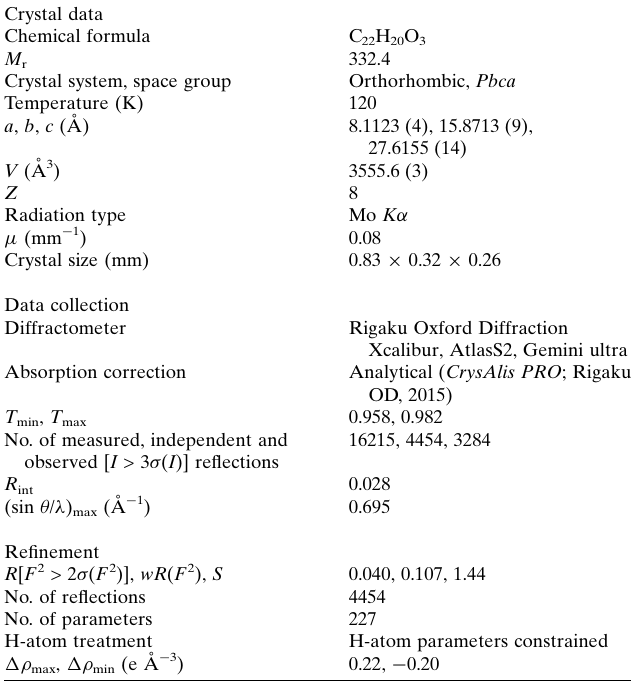
Table 2 Experimental details.